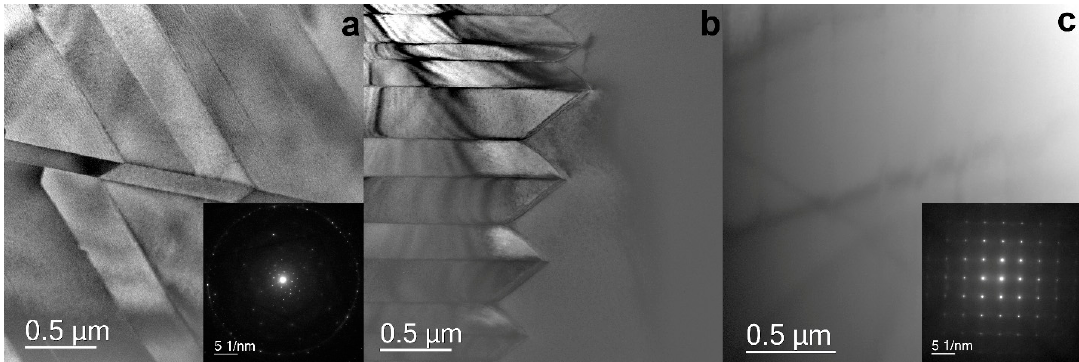
Figure 5. TEM images of top ( a ) and bottom ( b , c ) parts of 10Sc1CeSZ crystal. Insets: electron diffraction patterns of the respective crystal regions. patterns of the respective crystal